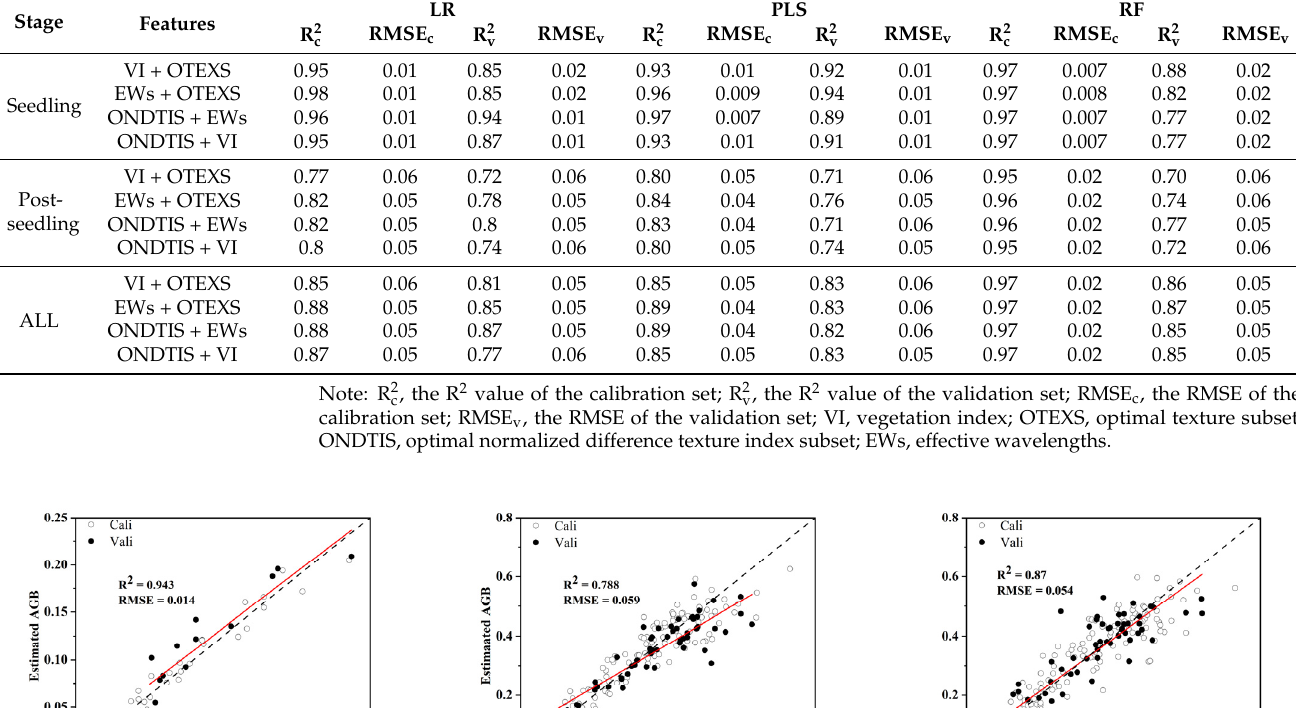
Table 9. Prediction results of LR, RF, and PLS with combined features across all different growth stages.